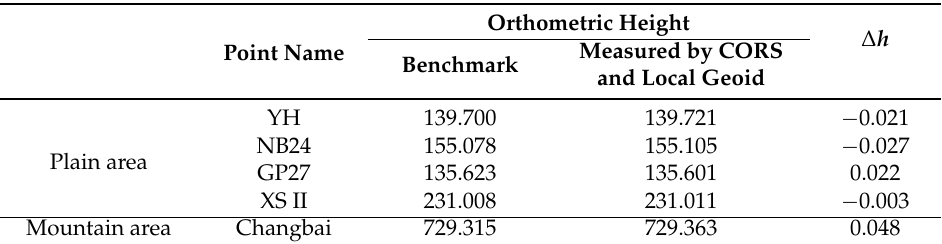
Table 4. The validation of the local geoid with respect to CGCS2000 (m).